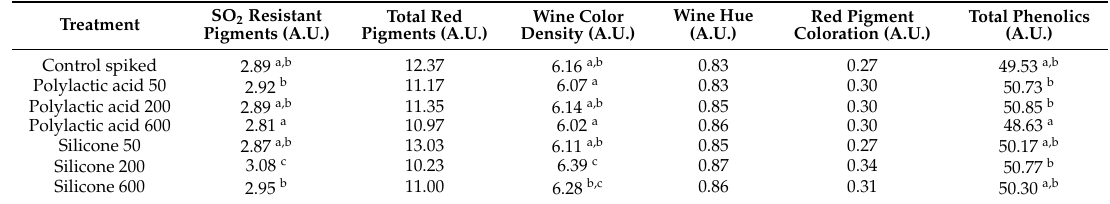
* Means with different letters are significantly different (ANOVA followed by Tukey’s HSD 0.05